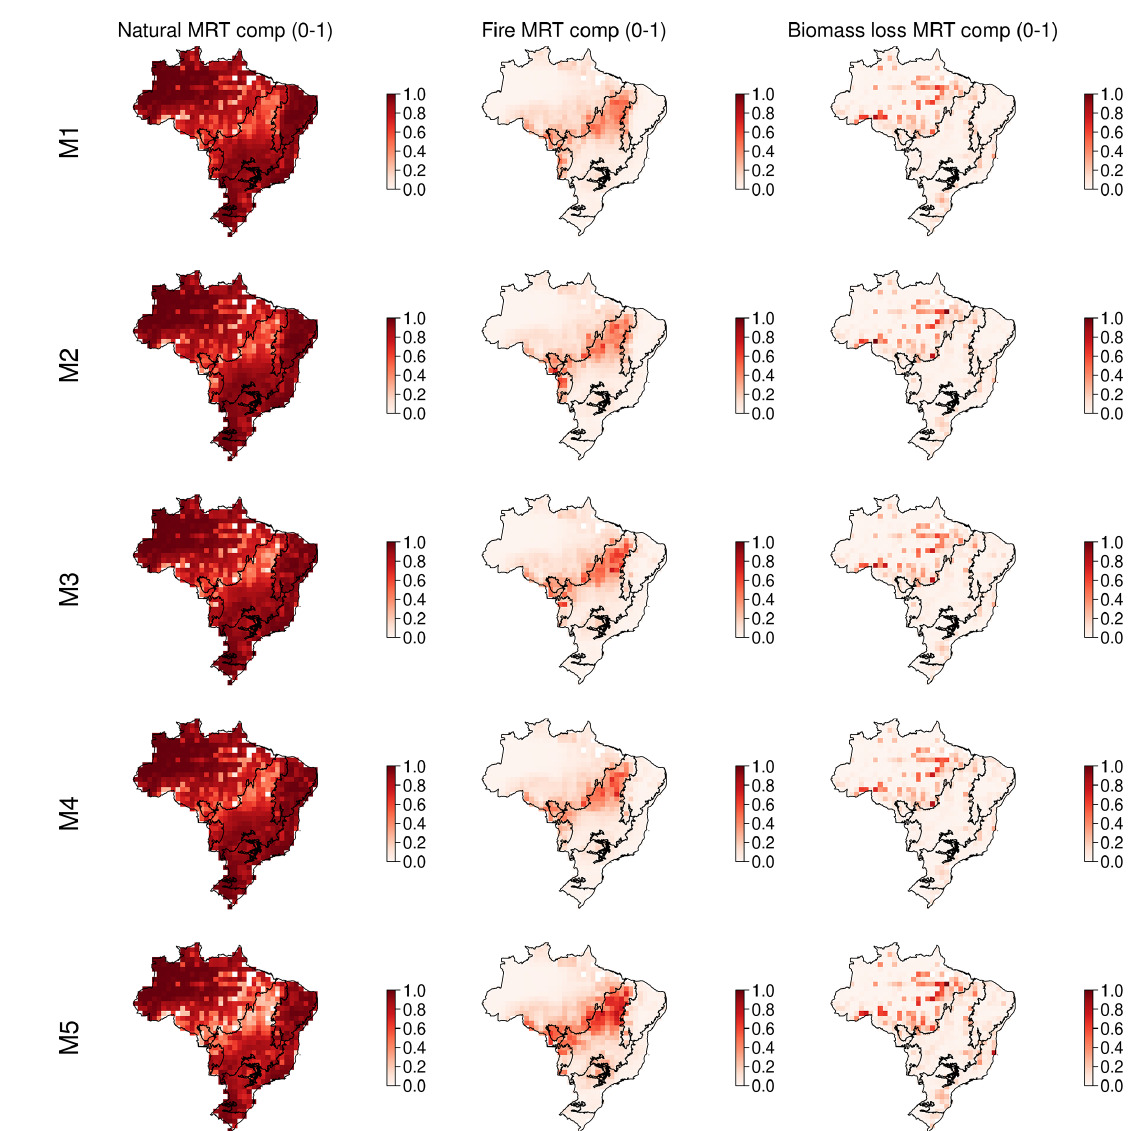
Figure A14. Maps of DALEC model estimates of the contribution of natural, fire and biomass removals to biomass mean residence time. The mapped values are estimated from the pixel-level median